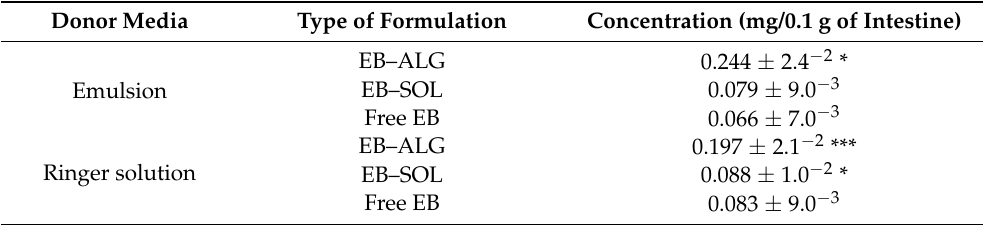
Table 3. Accumulated EB uptake in biological membrane in Ussing chambers.